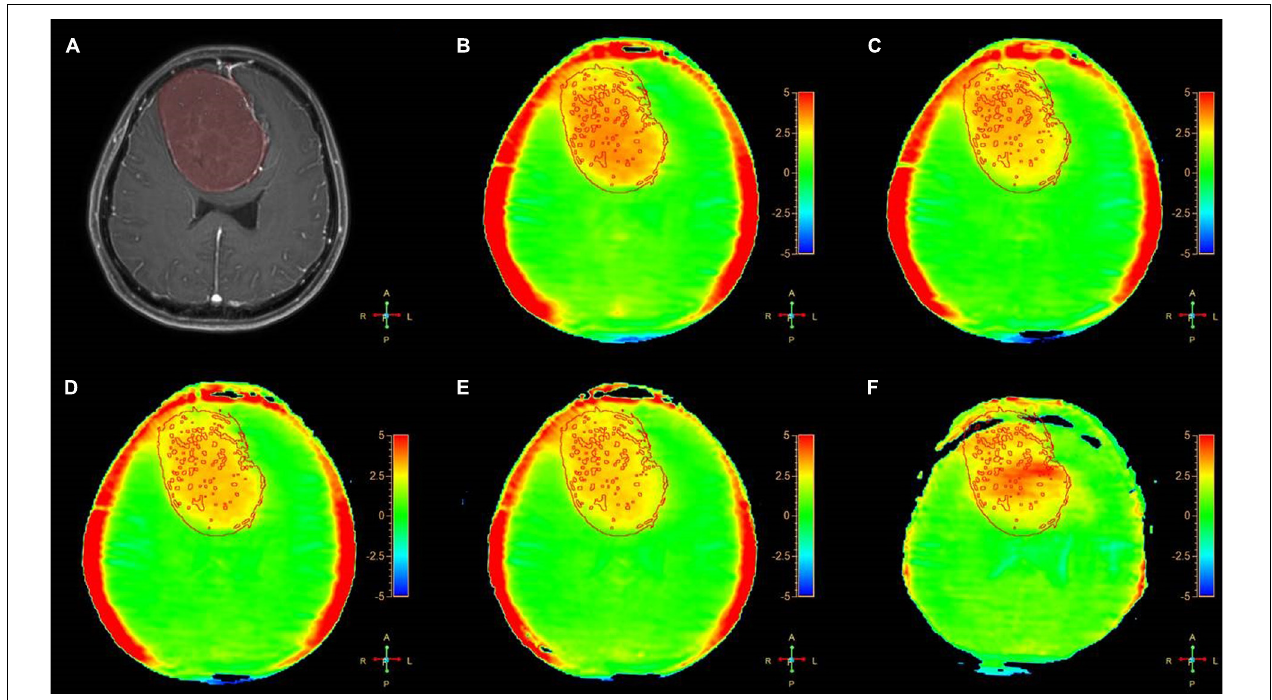
FIGURE 2 | A 54-year-old female patient with meningiomas in brain: (A) Gd-T1W; (B–F) APTw images by SENSE (AF 1.6) and CS-SENSE (AFs of 2, 3, 4, and 5). The ROIs were obtained manually on the Gd-T1W image and copied to the others as